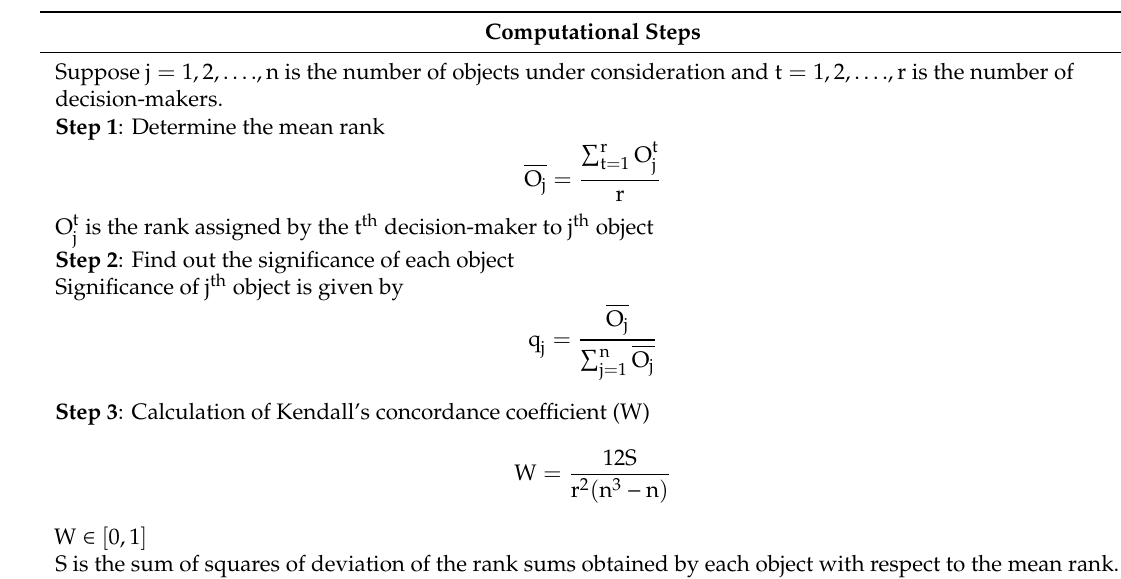
Table 6. Calculation of Kendall’s concordance coe ffi